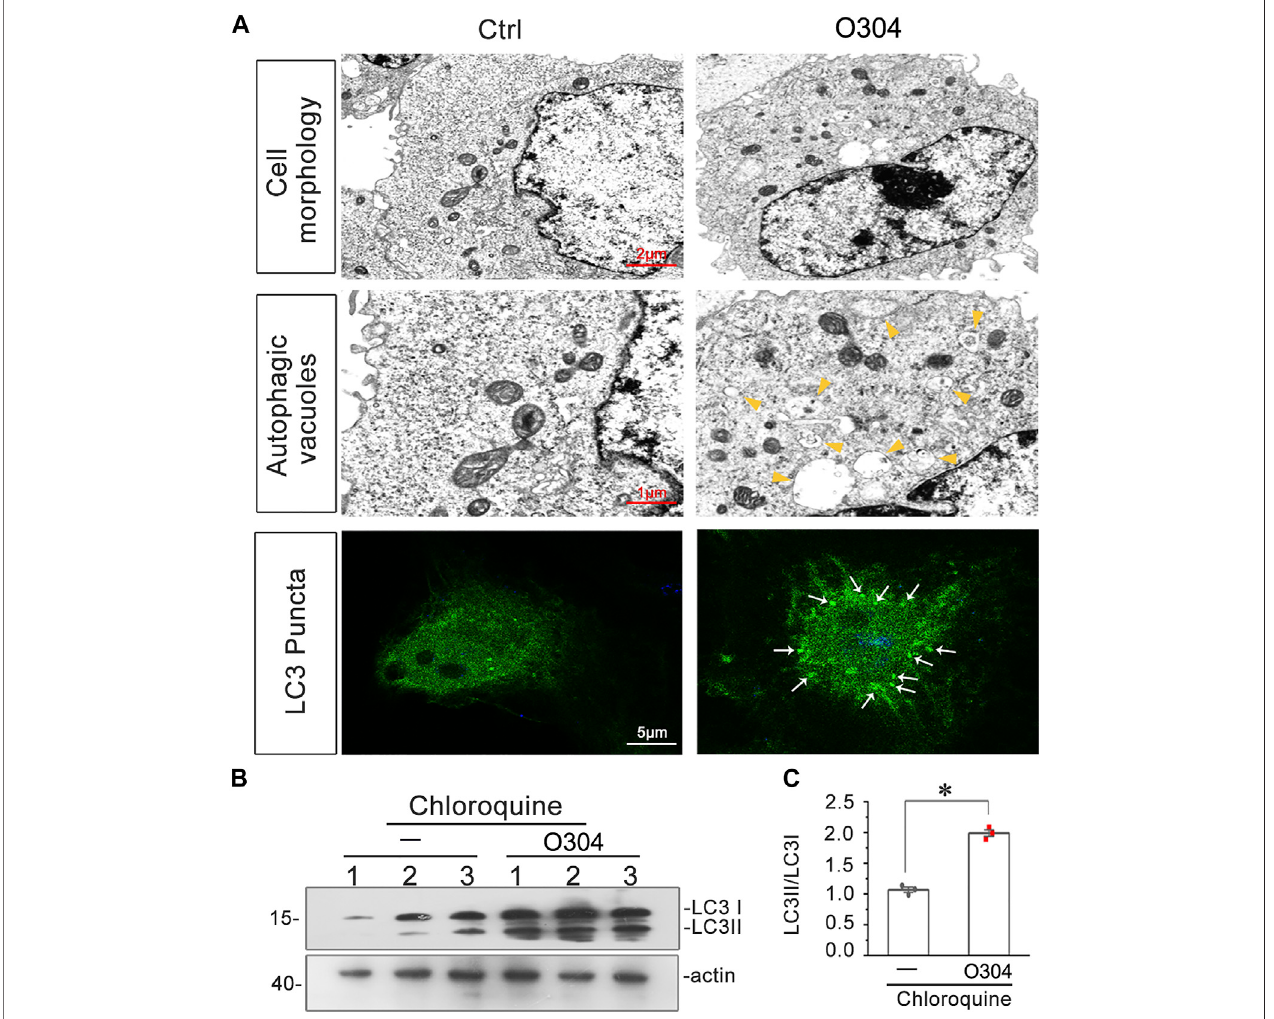
FIGURE10 | O304promotes autophagic fl ux in vitro . (A) Representativeelectron microscopy(TEM) micrographs show that O304increased autophagic vacuoles (yellow arrowheads). HKC-8 cells were treated with O304 (50 nM) for 60 h. Representative micrographs showO304 enhanced LC3B formation. HKC-8 cells were transiently transfected with GFP-LC3B plasmid for 24 h, and were then stimulated with or without O304 (50 nM) for 60 h. The cells were observed by fl uorescence microscopy. (B,C) Representative western blot shows that O304 enhanced LC3BII formation. HKC-8 cells were treated with chloroquine (50 μ M) and co-treated with or without O304 (50 nM) for 60 h * p < 0.05 versus chloroquine alone ( n =